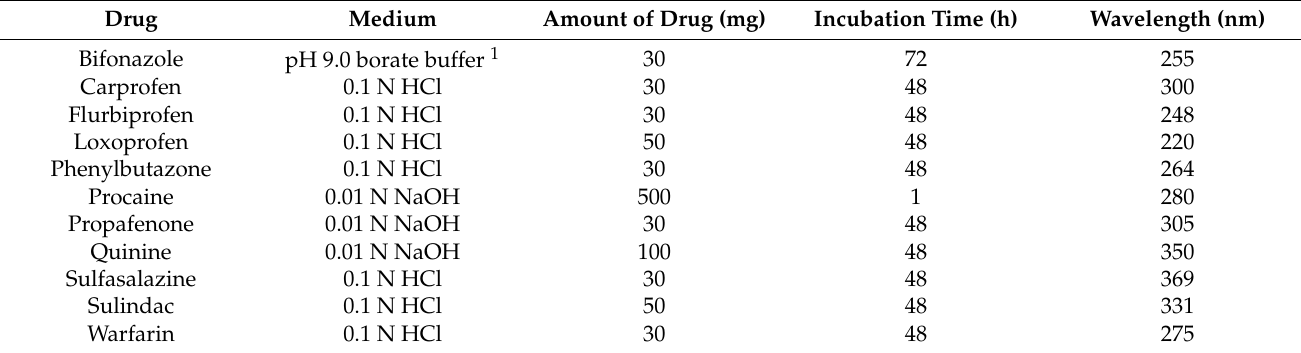
Table 1. Experimental conditions of intrinsic solubility